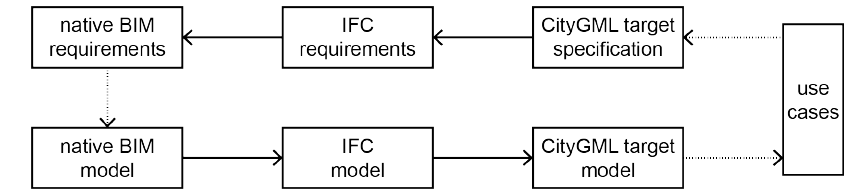
Figure 2. A flowchart of the project: from use cases to native BIM requirements and from a native BIM model to a CityGML model and its